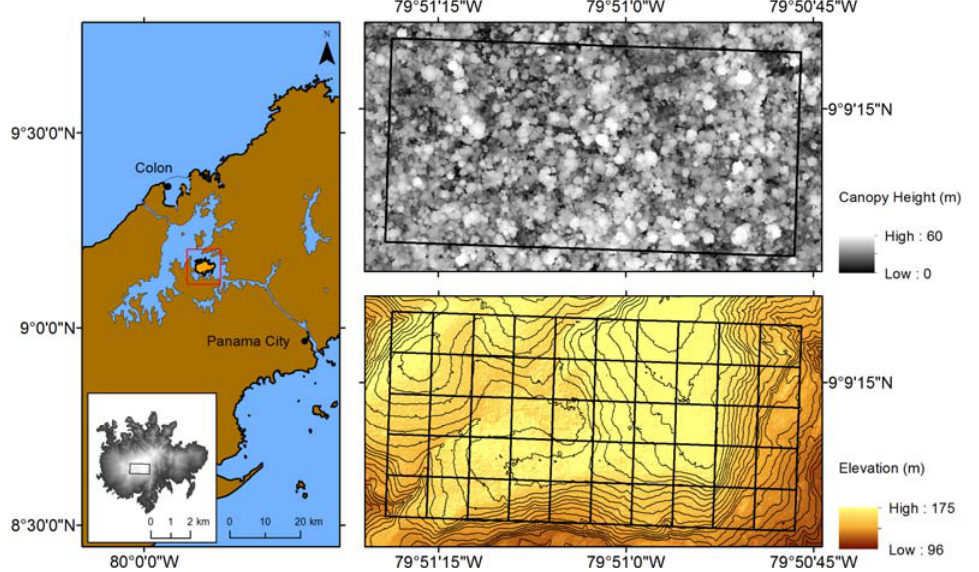
Figure 1. Geographic location of study area: ( Left ) Canal Zone with Barro Colorado Island (inset and red square). ( Right ) 50-ha Forest Dynamics Plot on Barro Colorado Island with ( Upper ) maximum canopy height (m) from lidar digital canopy surface model and ( Lower ) elevation (m) from lidar digital elevation model with 1.0-ha